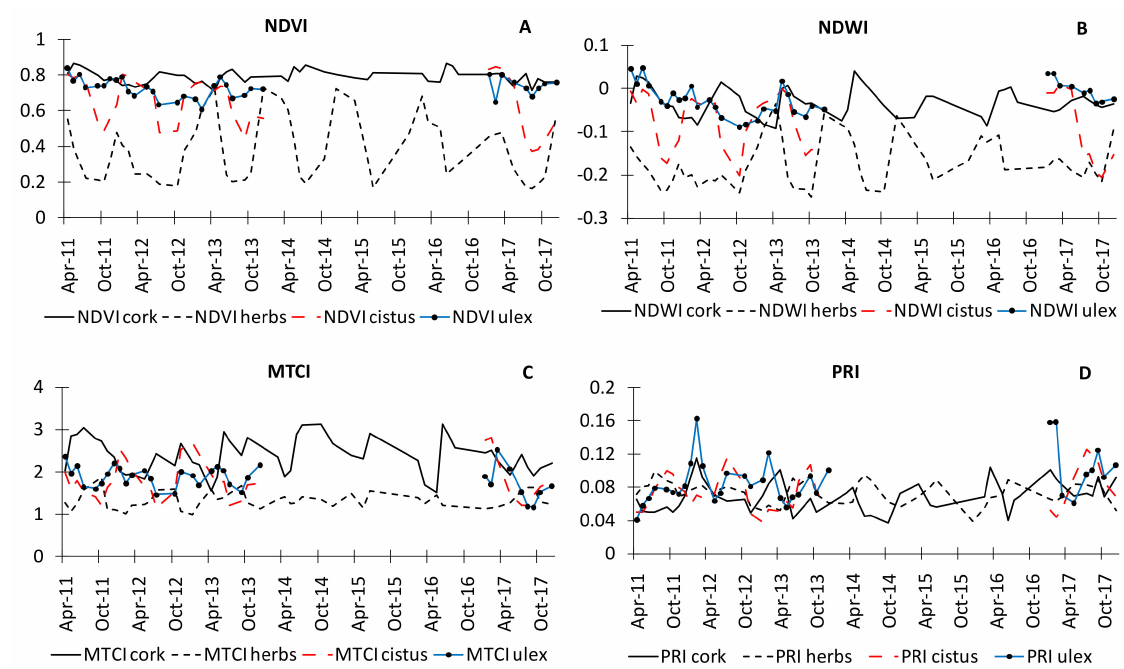
Figure 5. Vegetation indices time series during the study period (2011–2017) for cork oak, herbaceous vegetation, cistus and ulex: NDVI ( A ), NDWI ( B ), MTCI ( C ) and PRI ( D ). Each point represents the average of 4 replicates for cork oak, 4 replicates for cistus, 4 replicates for ulex and 8 replicates for herbaceous vegetation. Shrubs show a gap in spectral data measurements between 2014 and 2016, due to clear-cutting that occurred in 2014. Table 2. Maximum, minimum and amplitude values for cork oak, herbaceous vegetation, Cistus salvifolius and Ulex airensis for the vegetation indices NDVI, NDWI, MTCI and PRI. NDVI NDWI MTCI PRI Cork oak